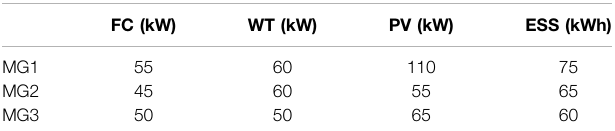
TABLE 1 | Installed capacity of each MG.